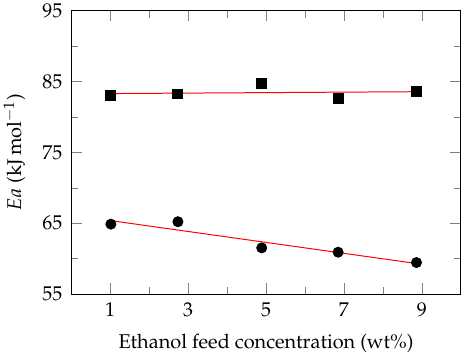
Figure 6. Effect of Ethanol feed concentration on the apparent activation energy. Ethanol ( (cid:4) ), water ( ), suggested behavior (cid:32)